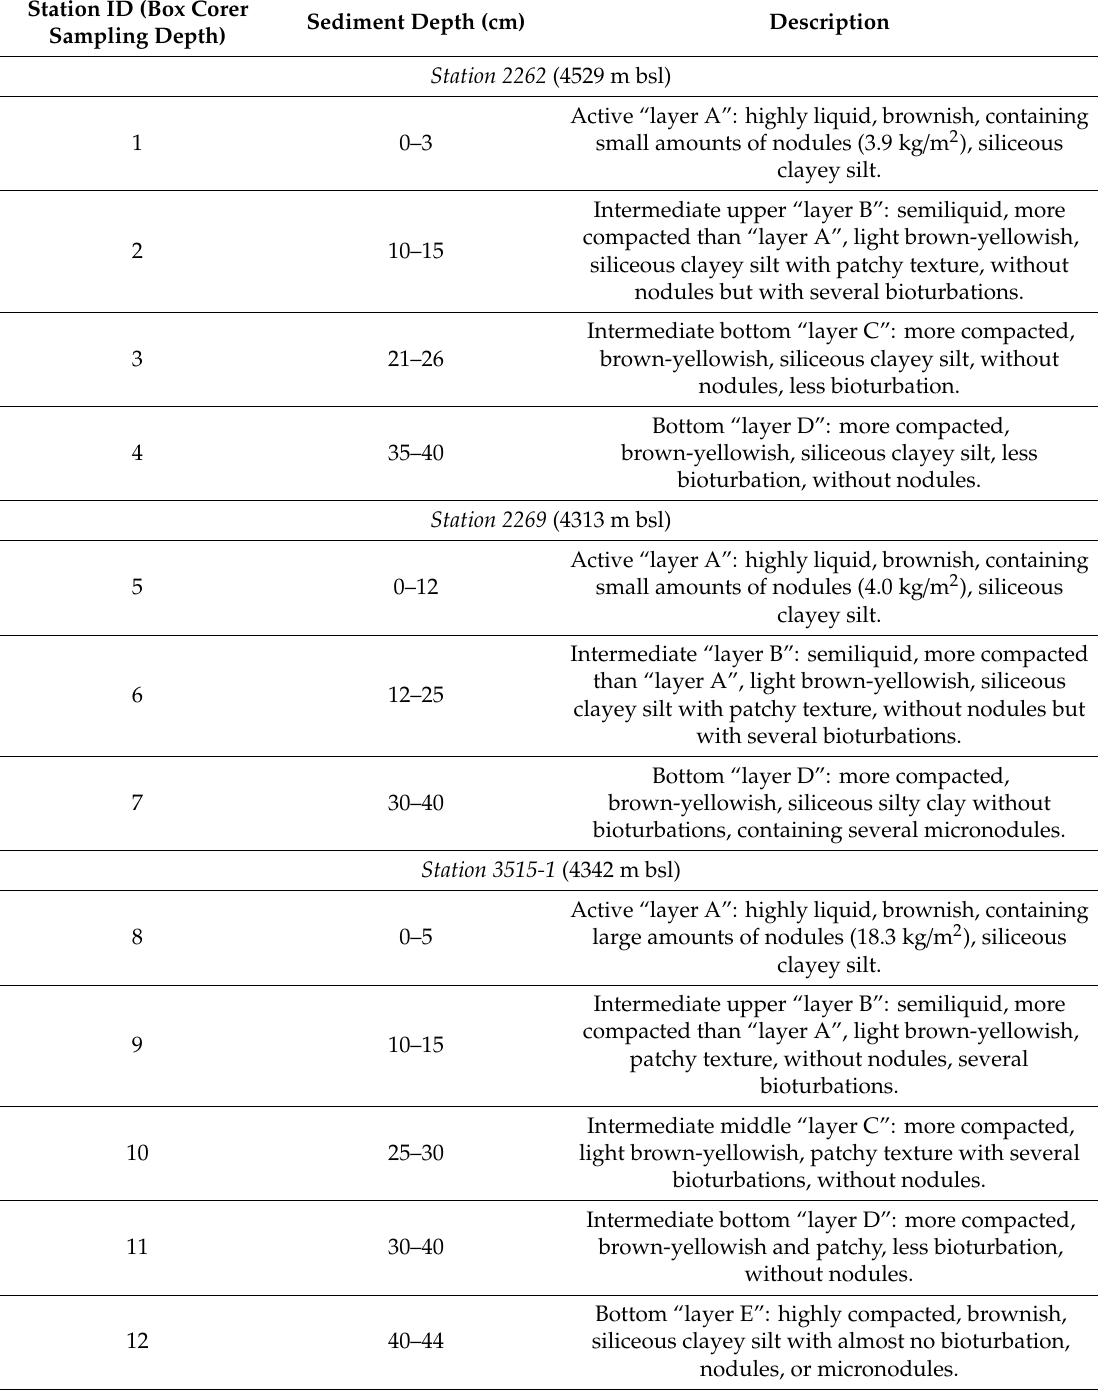
Table 1. General description of analysed samples (n =